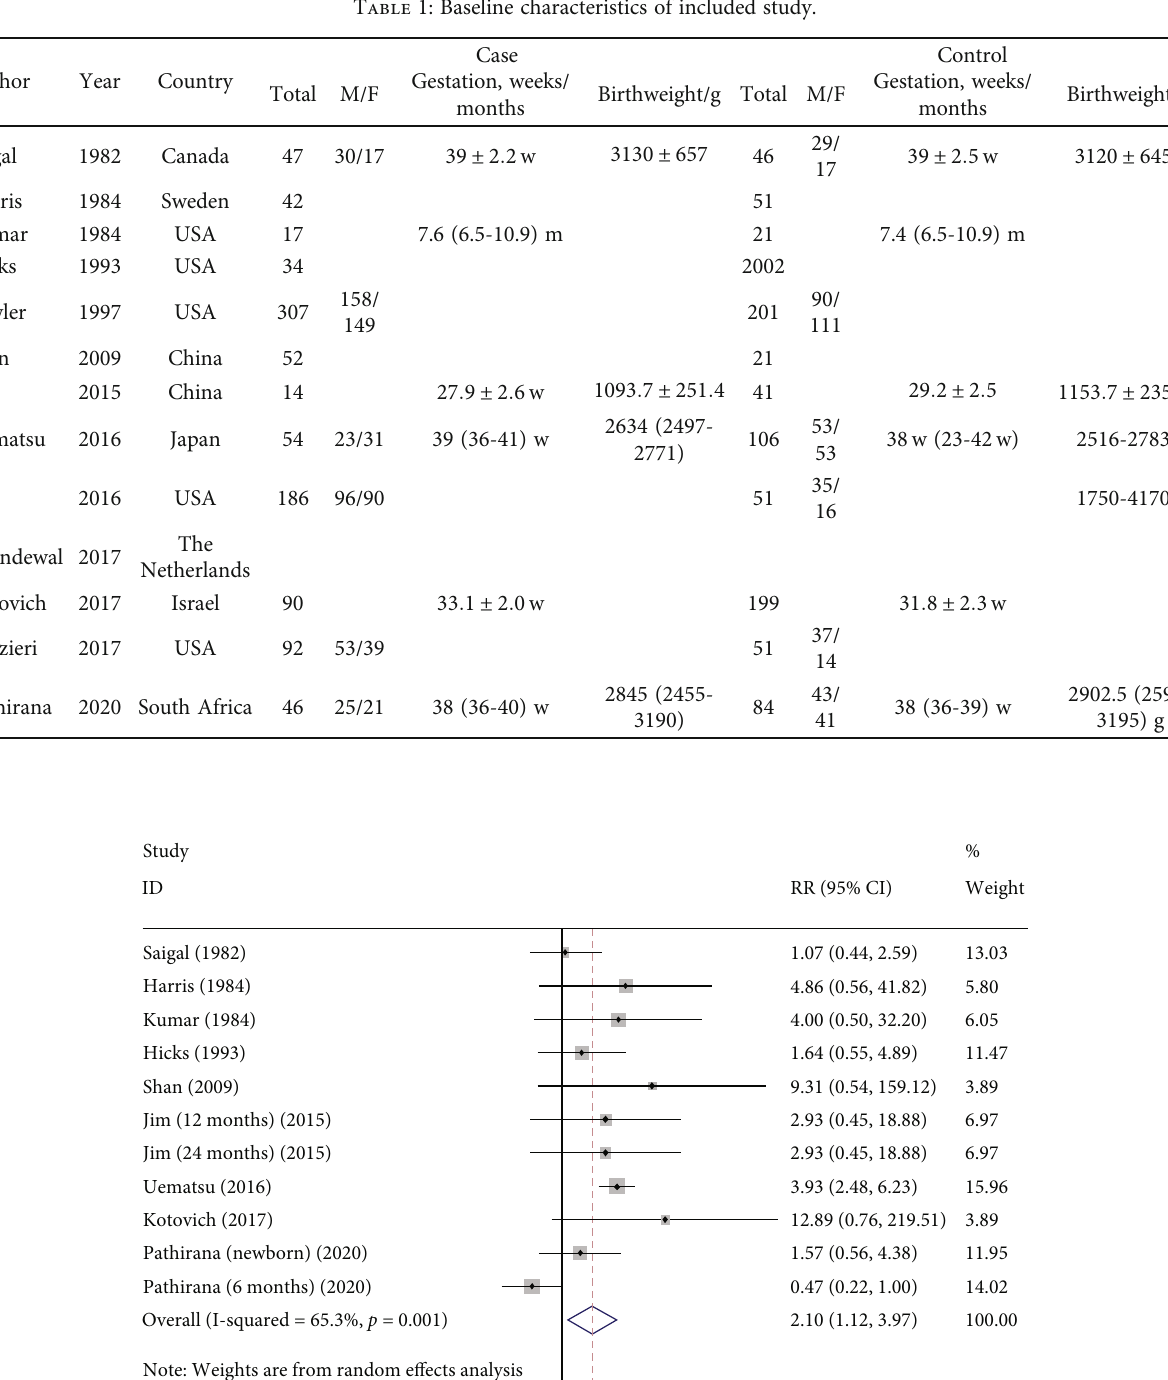
Table 1: Baseline characteristics of included study.